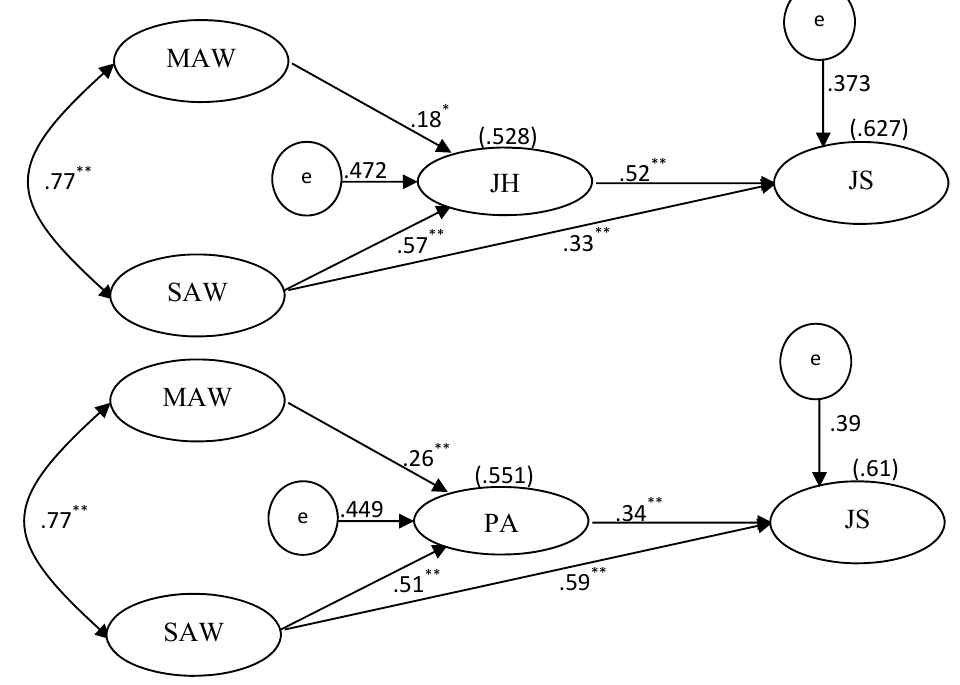
Fig. 2. The final and revised structural models of current